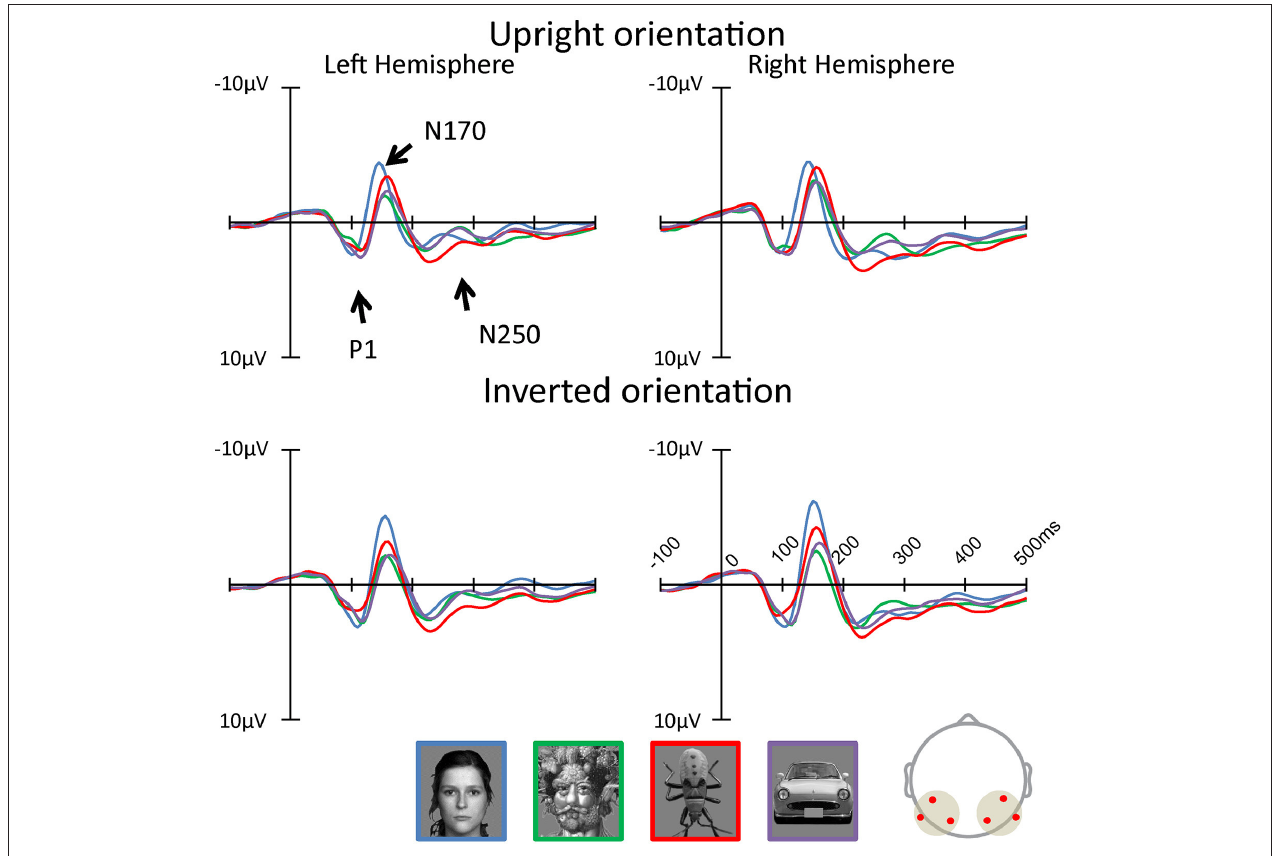
FIGURE 3 | The grand average of ERP waveforms elicited by each category in the upright and inverted orientations at the left and right pooled occipito-temporal electrode sites (waveforms averaged for electrodes P5/P9/PO7, P6/P10/PO8). In addition, the waveforms of inversion effect was calculated (see Supplementary Data Sheet 1, Supplementary Figure